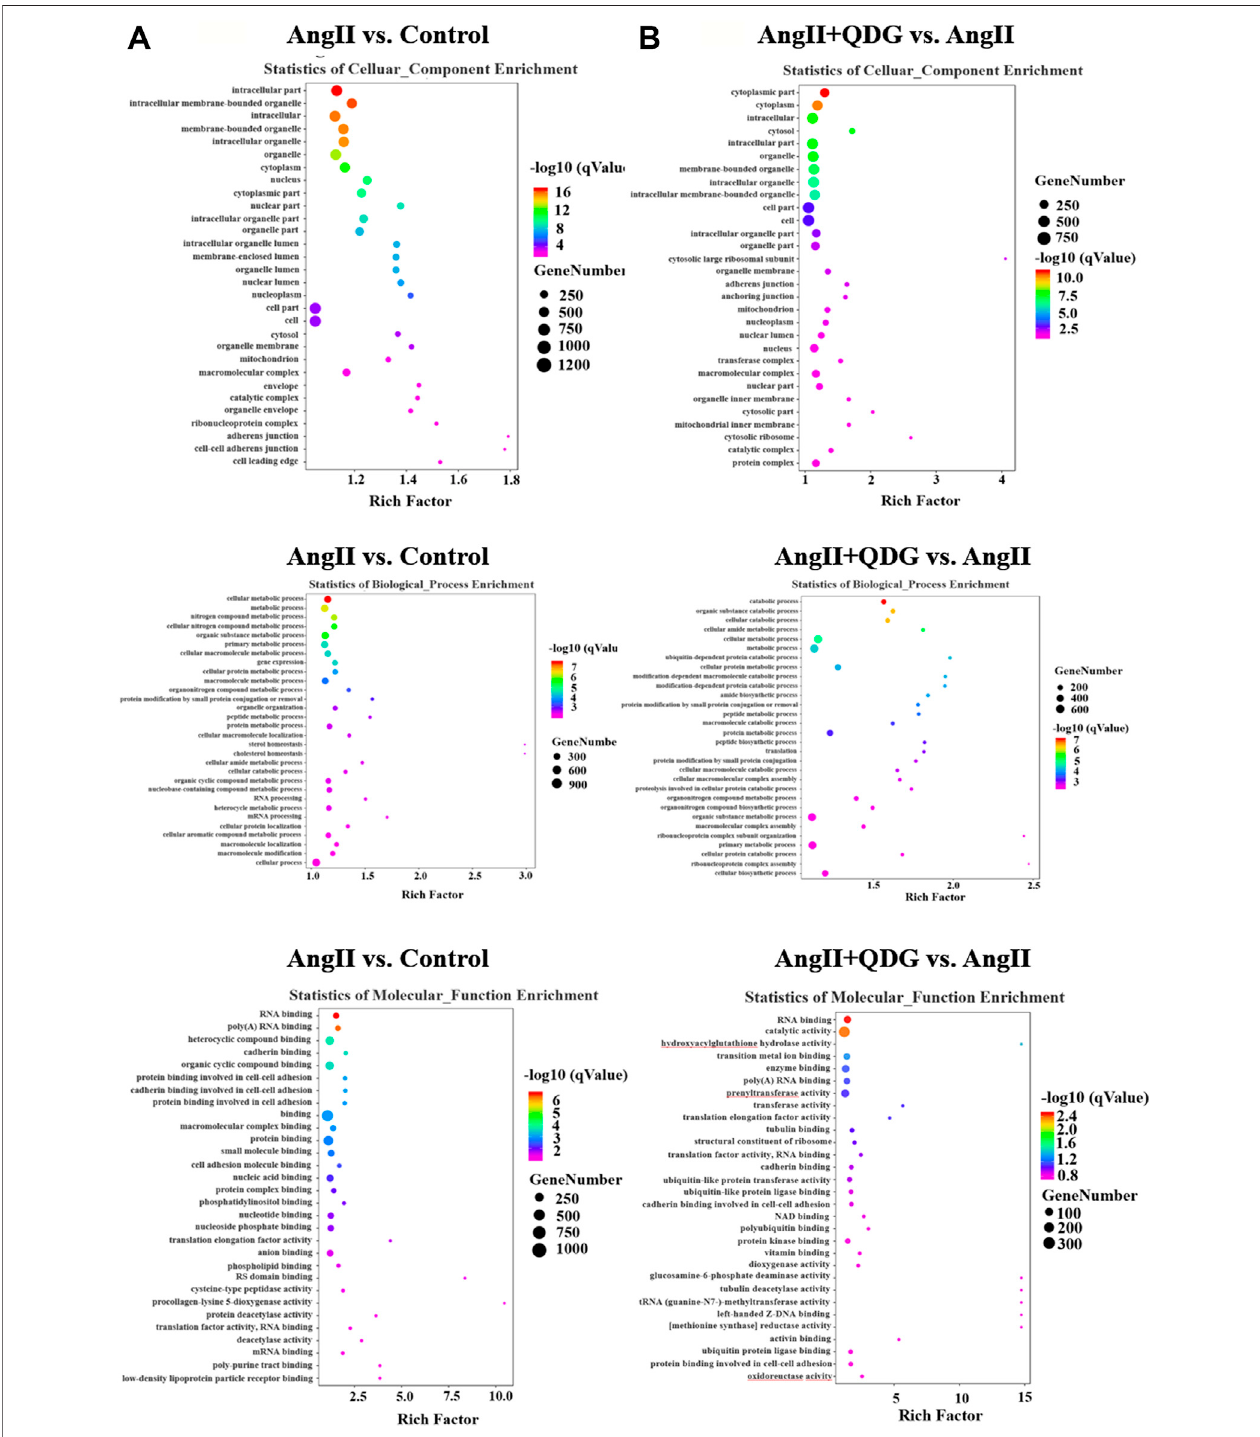
FIGURE 3 | GO enrichment analysis. GO enrichment analysis was performed based on the DETs from both comparisons of (A) Ang II vs. Control and (B) Ang II + QDG vs. Ang II. The top 30 enriched items of the cellular composition (left panel), biological processes (middle panel), and molecular function (right panel).